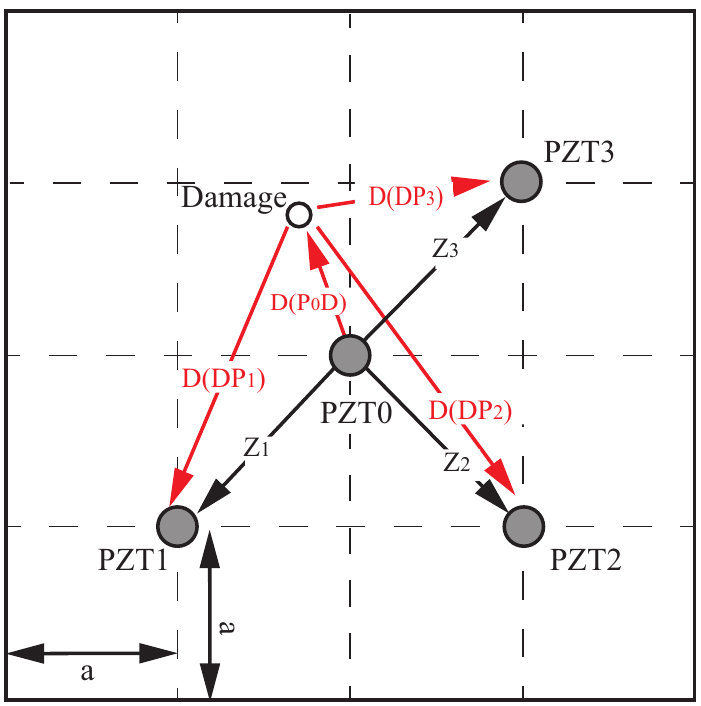
Figure 1. The schematic of the improved